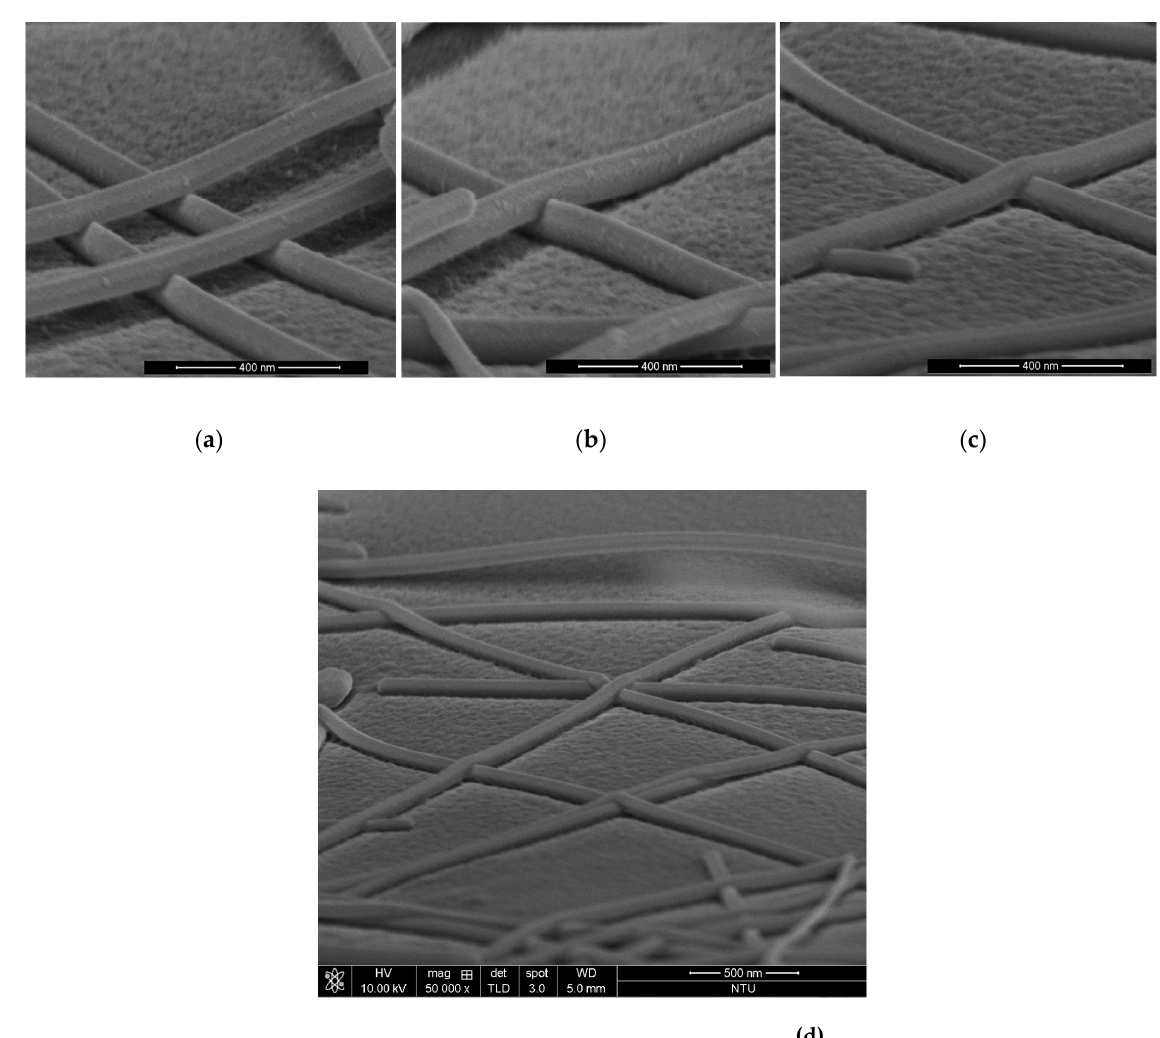
Figure 7. SEM images of AgNWs on PET substrate after laser nanowelding at laser power of ( a ) 28 kW/cm 2 , ( b ) 40 kW/cm 2 and ( c ) 50 kW/cm 2 with the fixed scan speed of 100 mm/s and 5 scans; ( d ) a larger-scale SEM image of the sample in ( c ) showing no ablation or balling of AgNWs.